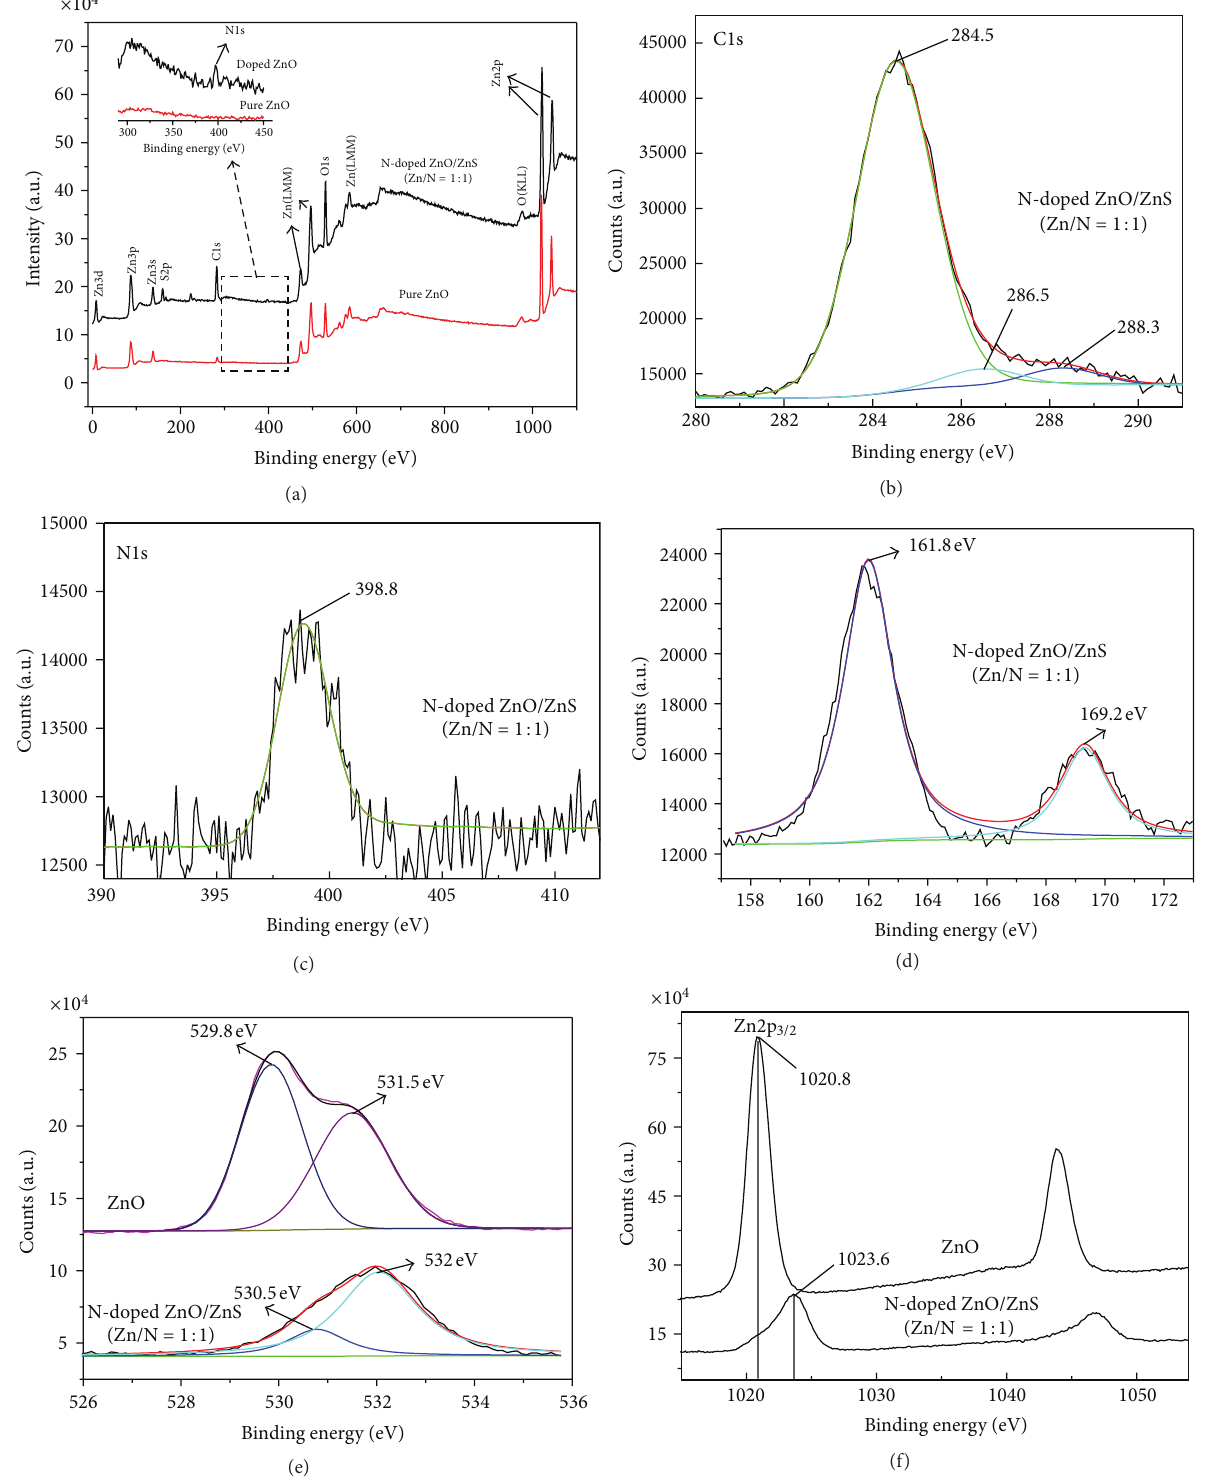
Figure 4: XPS spectra of samples: (a) XPS survey spectra, (b) C1s, (c) N1s, (d) S2p, (e) O1s, and (f) Zn2p